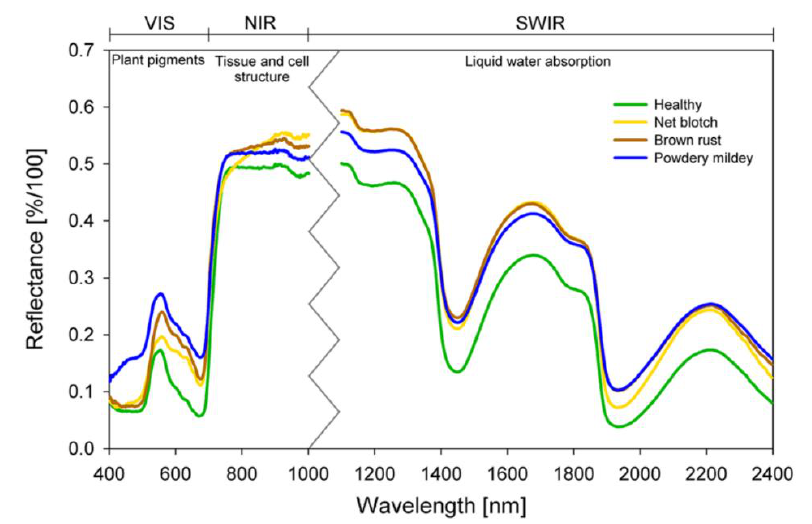
Figure 4. Spectral signatures of healthy barley leaves (green) and diseased barley leaves with net blotch (yellow), brown rust (brown), and powdery mildew (blue), respectively, at 10 days after in- oculation. Sensors: “ PS V10E ” (400 – 1000 nm) and “ SWIR ” (1000 – 2500 nm) push broom scanners (Specim, Oulu, Finland). A zigzag line has been added to separate the discontinuous parts of the spectral curves. All measurements were taken with the HyperART setup according to Thomas et al. [34] (Reprinted with permission, copyright 2022 Anne-Katrin Mahlein). VIS — visual, NIR — near- infrared, SWIR — shortwave infrared (parts of the electromagnetic spectrum).